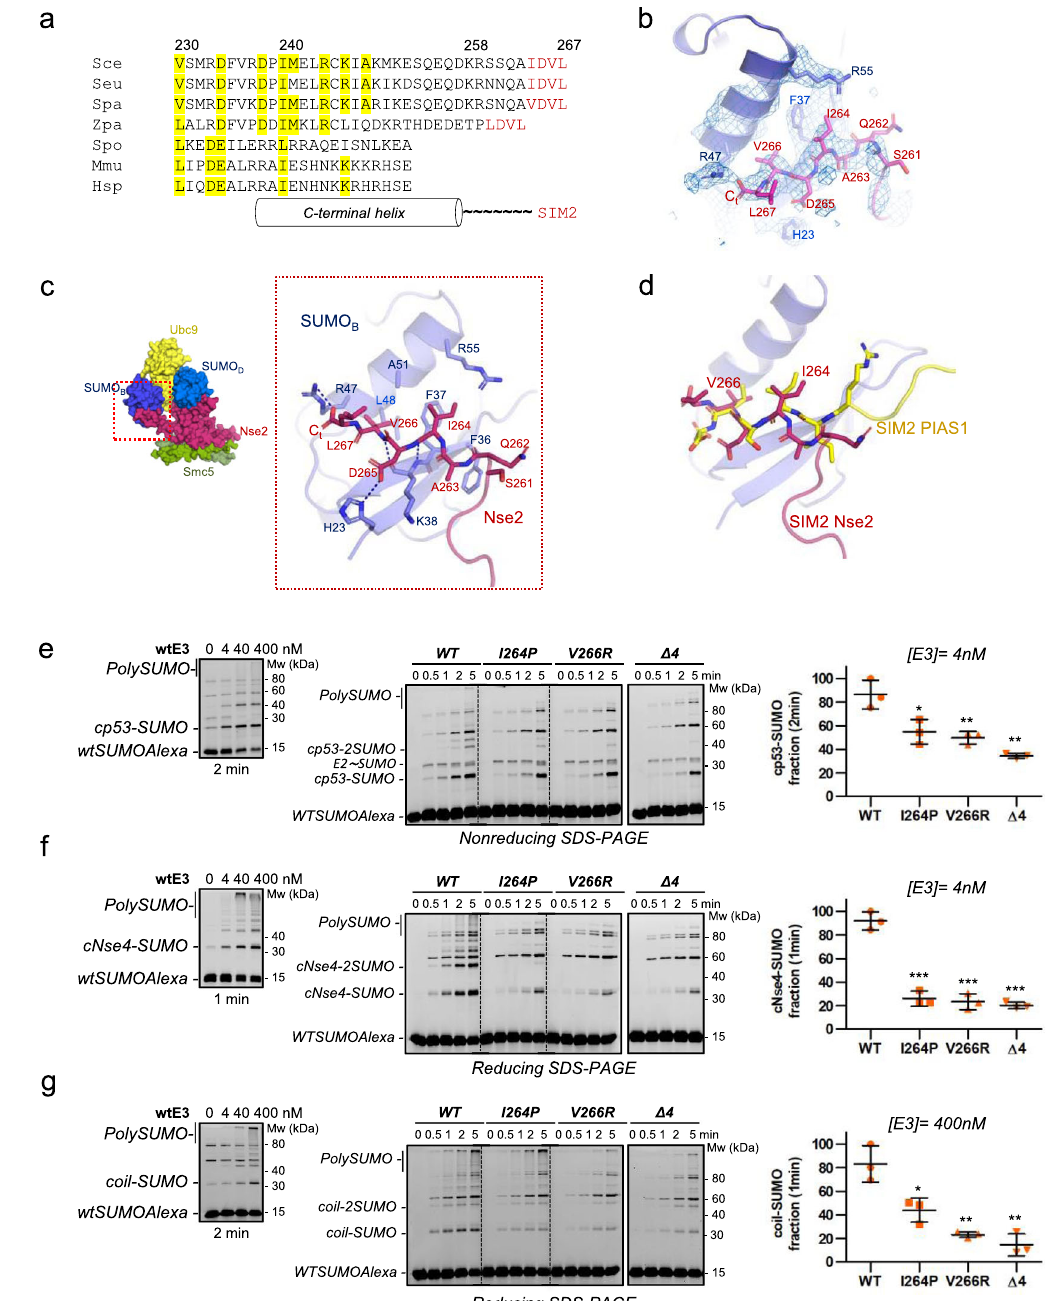
Fig. 2 Role of a C-terminal SIM motif (SIM2) in the catalytic activity of Nse2. a Multiple alignment of Nse2 sequences from Saccharomyces cerevisiae , S. eubayanus , S. paradoxus , Zygos. parabailli , Schizos. pombe , Mus musculus and Homo sapiens (in red SIM2). b Electron density maps of SIM2 Nse2 and SUMO B . c . Stick representation of the complex between SIM2 and SUMO B . d Structural alignment of Nse2 SIM2 and SIM2 from PIAS1-peptide complex (PDB 6V7P), evidencing similar locations of Ile264 and Val266 in the SUMO B cavity. e – g Multiple-turnover SUMOylation reactions of yeast Nse2/Arm-Smc5 complex (wild type and mutants) using cP53, cNse4 and coil/Smc5 substrates. Enzyme concentration was chosen based on the concentration dependence assay (left). Error bars showing that point mutations or deletion of SIM2 reduce E3 activity (right). Data values represent the mean ±SD, n = 3 technical replicates. Signi fi cance was measured by a two-tailed unpaired t-test relative to wild type. All data were analyzed with a 95% con fi dence interval. * P < 0.05, ** P < 0.01, *** P < 0.001. Exact P values from the left to right: ( e ) 0.027, 0.009, 0.002; ( f ) 0.0003, 0.0003, 0.0001; ( g ) 0.021, 0.002, 0.002. Source data are provided as a Source Data fi